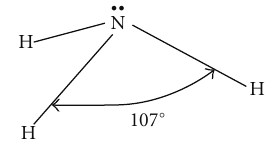
Figure 2: Ammonia molecule.